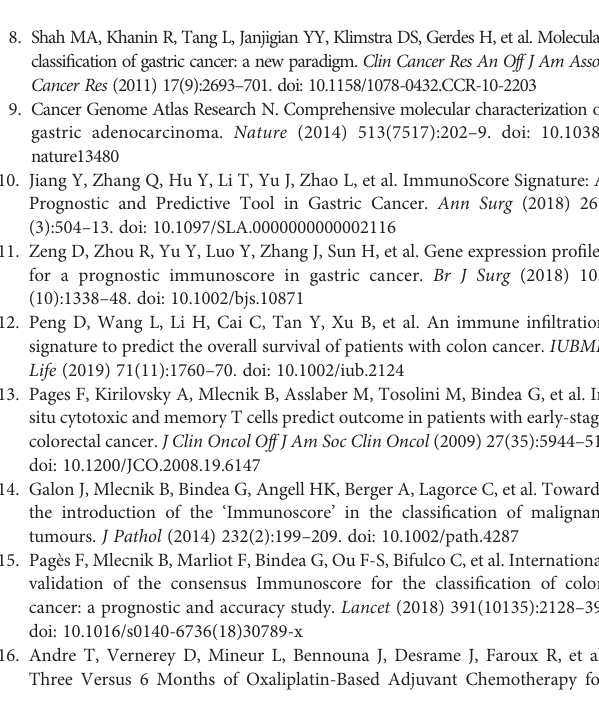
Supplementary Figure 2 | Heatmap summarizing the correlation between IS and clinicalpathological characteristics in the testing cohort. Supplementary Figure 3 | IS analysis of GC patients. (A) IS distribution, status of recurrence and survival, distribution of eight immune cells of 273 training cohort patients. (B) IS distribution, status of recurrence and survival, distribution of eight immune cells of 365 testing cohort patients. DFS , disease free survival; OS , overall survival; GC , gastric cancer. Supplementary Figure 4 | Kaplan-Meier survival analysis of DFS (left pane) and OS (right pane) according to IS in TNM subgroups of patients with GC in the testing cohort. (A) Stage I ( n = 68); (B) Stage II ( n = 167); (C) Stage III ( n = 130). DFS , disease free survival; OS , overall survival; GC , gastric cancer. Supplementary Figure 5 | ROC curves compare the prognostic accuracy of the IS with TNM in the training and testing cohorts. (A) Comparison of the accuracy of DFS by IS and TNM in the training and testing cohorts. (B) Comparison of the accuracy of OS by IS and TNM in the training and testing cohorts. ROC , receiver operator characteristic; AUC , area under curve. Supplementary Figure 6 | Kaplan-Meier survival analysis of DFS (left pane) and OS(rightpane)accordingtoISinLaurensubtypeofthetrainingcohort. (A) Intestinal subtype ( n = 142); (B) Diffuse subtype ( n = 115); (C) Mixed subtype ( n = 16); (D) The survival impact of IS in Lauren subtype. HR , hazard ratio; DFS , disease free survival; OS , overall survival. Supplementary Figure 7 | Kaplan-Meier survival analysis of DFS (left pane) and OS (right pane) according to IS in MSS/MSI subtypes of the training cohort. (A) MSI subtype ( n = 67); (B) MSS subtype ( n = 206); (C) The survival impact of IS in MSI/ MSS subtypes. HR , hazard ratio; MSS , microsatellite stability; MSI , microsatellite instability; DFS , disease free survival; OS overall survival. Supplementary Figure 8 | Effects of adjuvant chemotherapy on DFS in different subgroups. Supplementary Figure 9 | PD-L1, CD40, CD47, CTLA4, GZMB, Tim-3, ICOS, IDO1, LAG3, and IFNG mRNA expression between the low- and high-IS groups. * P <